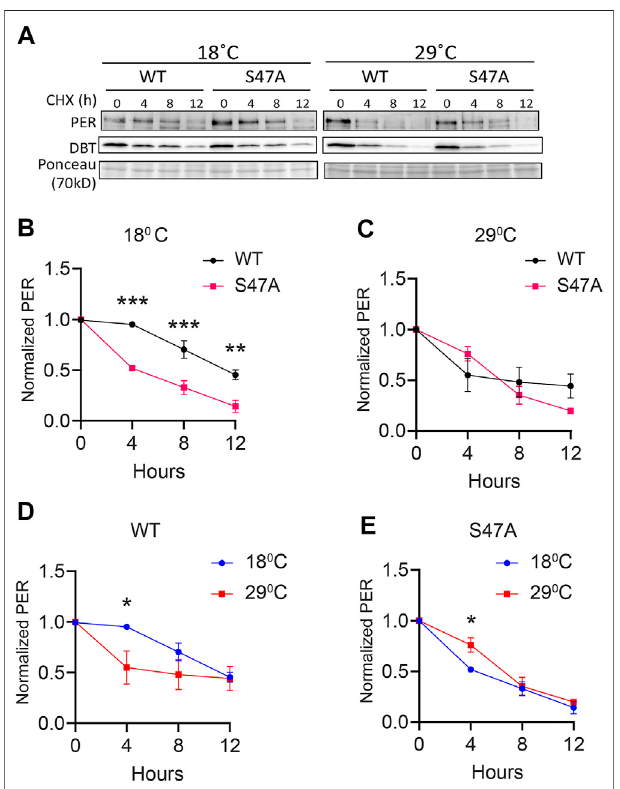
high and low temperatures.